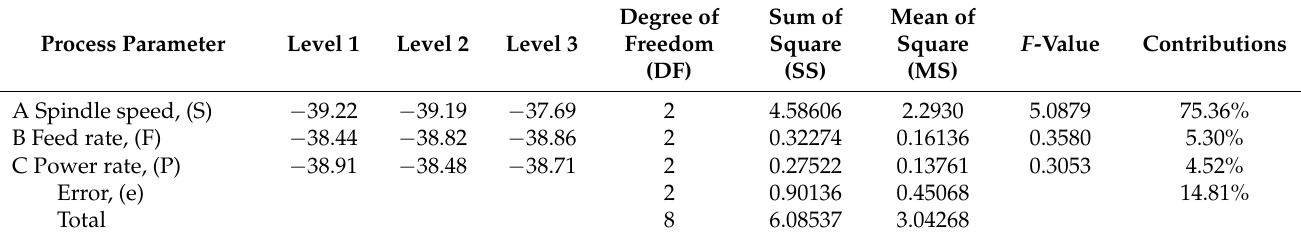
Figure 5. Evolutions of cutting force with the increase of drilling cycles under different process parameters. Table 3. ANOVA coefficients and mean S/N